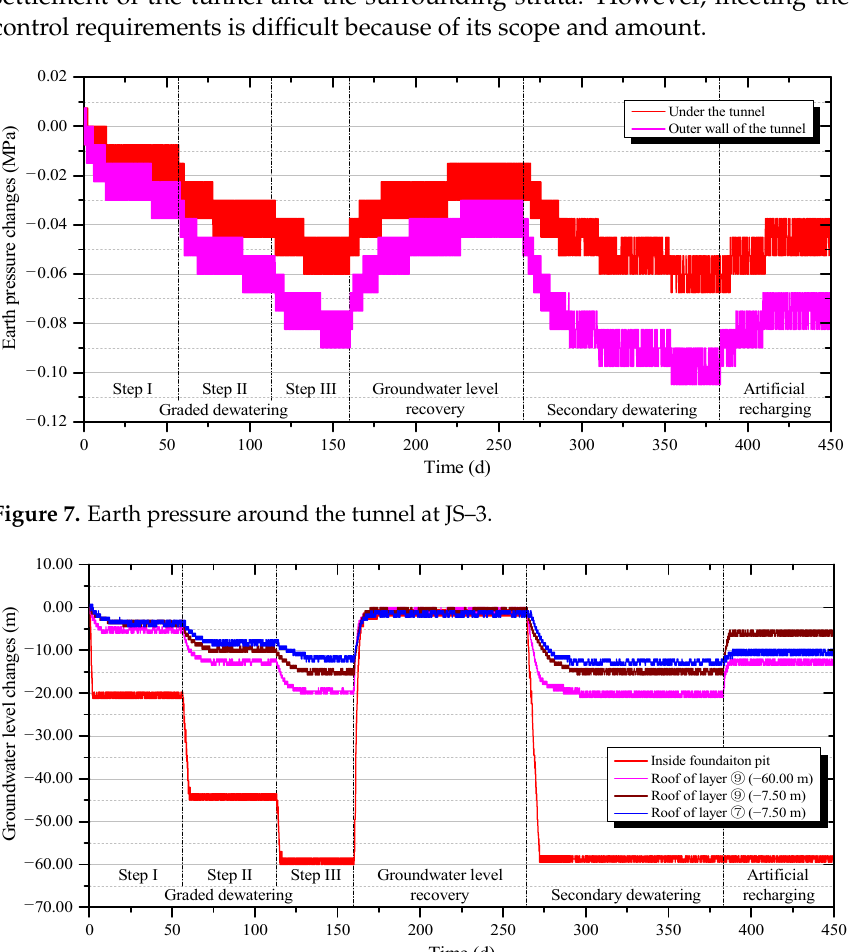
Figure 8. Groundwater level changes under the tunnel at JS–3.